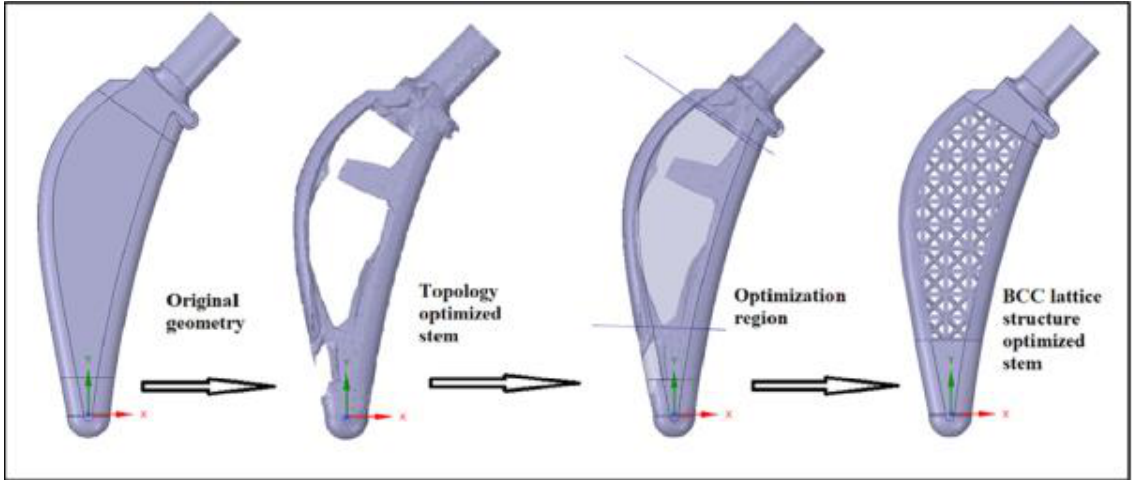
Figure 8. The process of hip stem topology optimization with a BCC lattice structure. Adapted with permission from [301]. 2022. permission from [301]